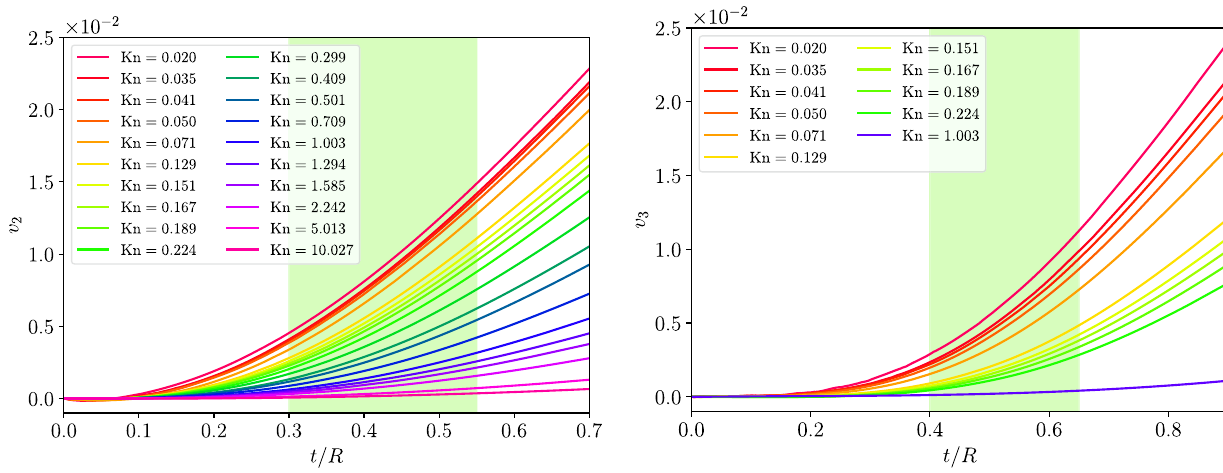
Fig. 1 v 2 (left) and v 3 (right) as function of t / R for different Knudsen numbers. The green shaded region marks the interval for the upper end points of the fits with Eq.